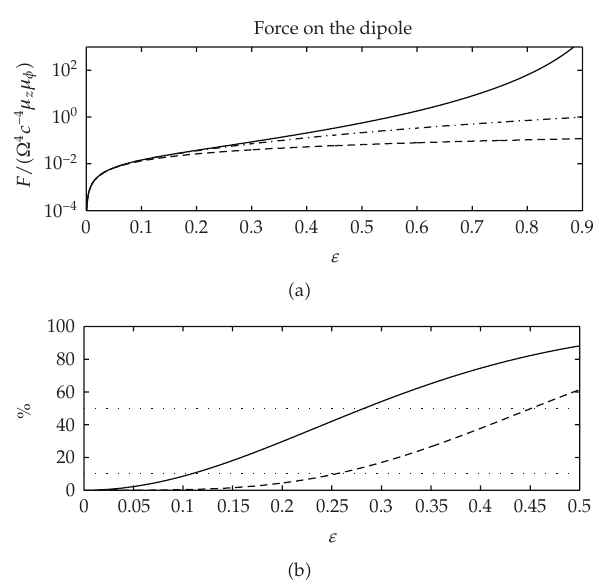
Figure 3: Comparison of the exact and approximate values for the function F , normalized to Ω 4 c − 4 μ z μ φ . In the upper panel, the solid line shows the (cid:2) numerically calculated (cid:3) exact function F , and the dashed and dash-dot lines show the approximations F 0 and F 0 (cid:10) F 1 , respectively. In the lower panel, the relative deviation (cid:2) in percent (cid:3) from the exact function values is shown for the approximations F 0 (cid:2) solid line (cid:3) and F 0 (cid:10) F 1 (cid:2) dashed line (cid:3) , respectively. The two dotted lines mark deviations of 10% and